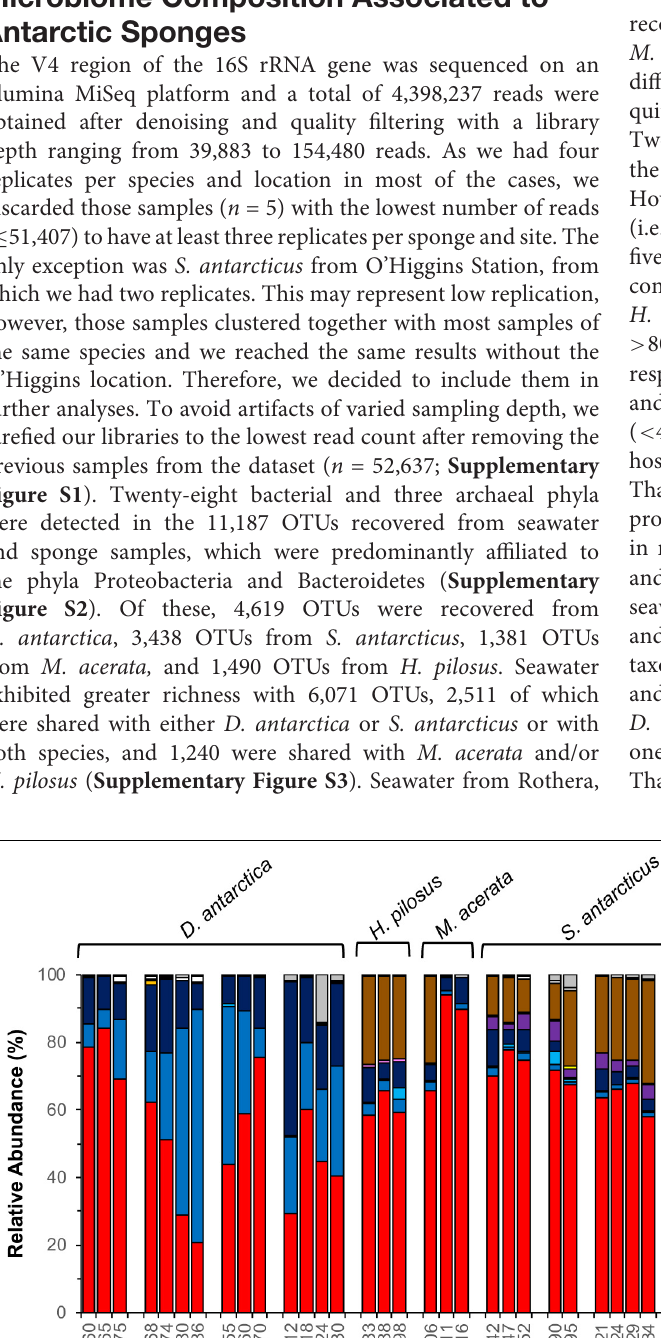
Frontiers in Marine Science |